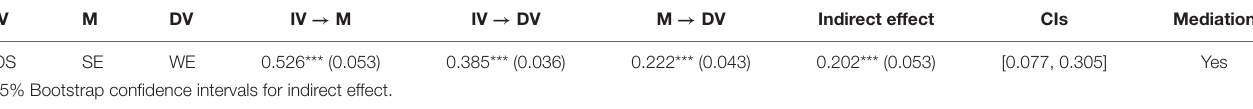
TABLE 5 | Results of mediating effect